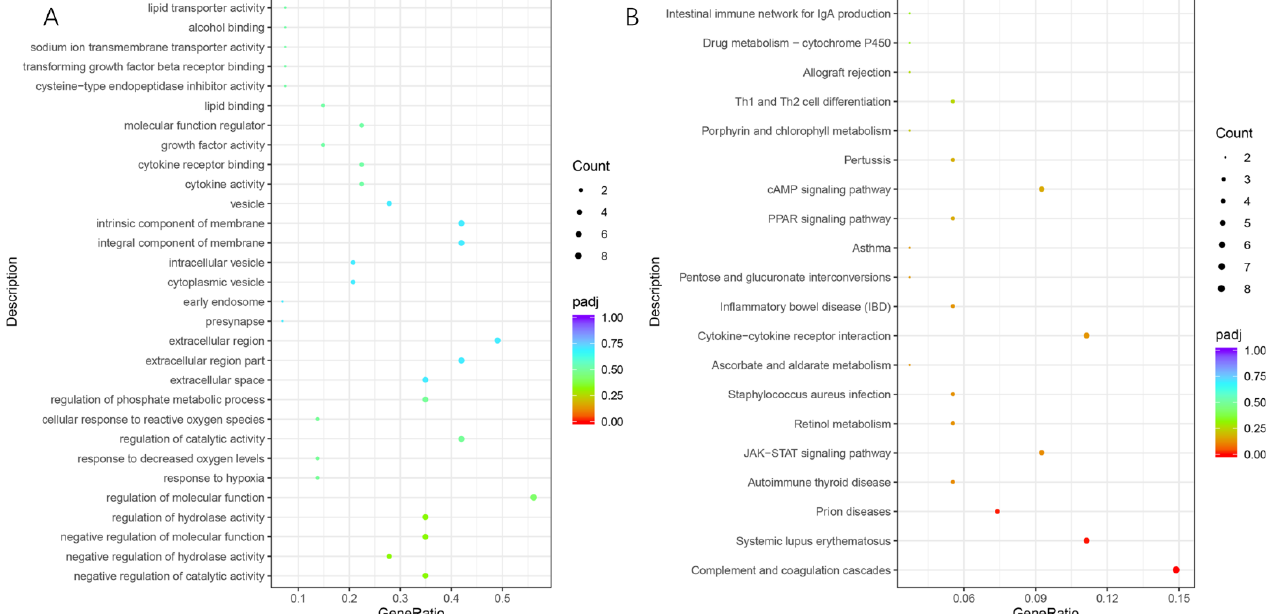
Figure 2. Enrichment of gene ontology (GO) terms ( A ) and KEGG pathways ( B ) in HL vs. LL. HL, liver samples of the high-EF group; LL, liver samples of the low-EF group.